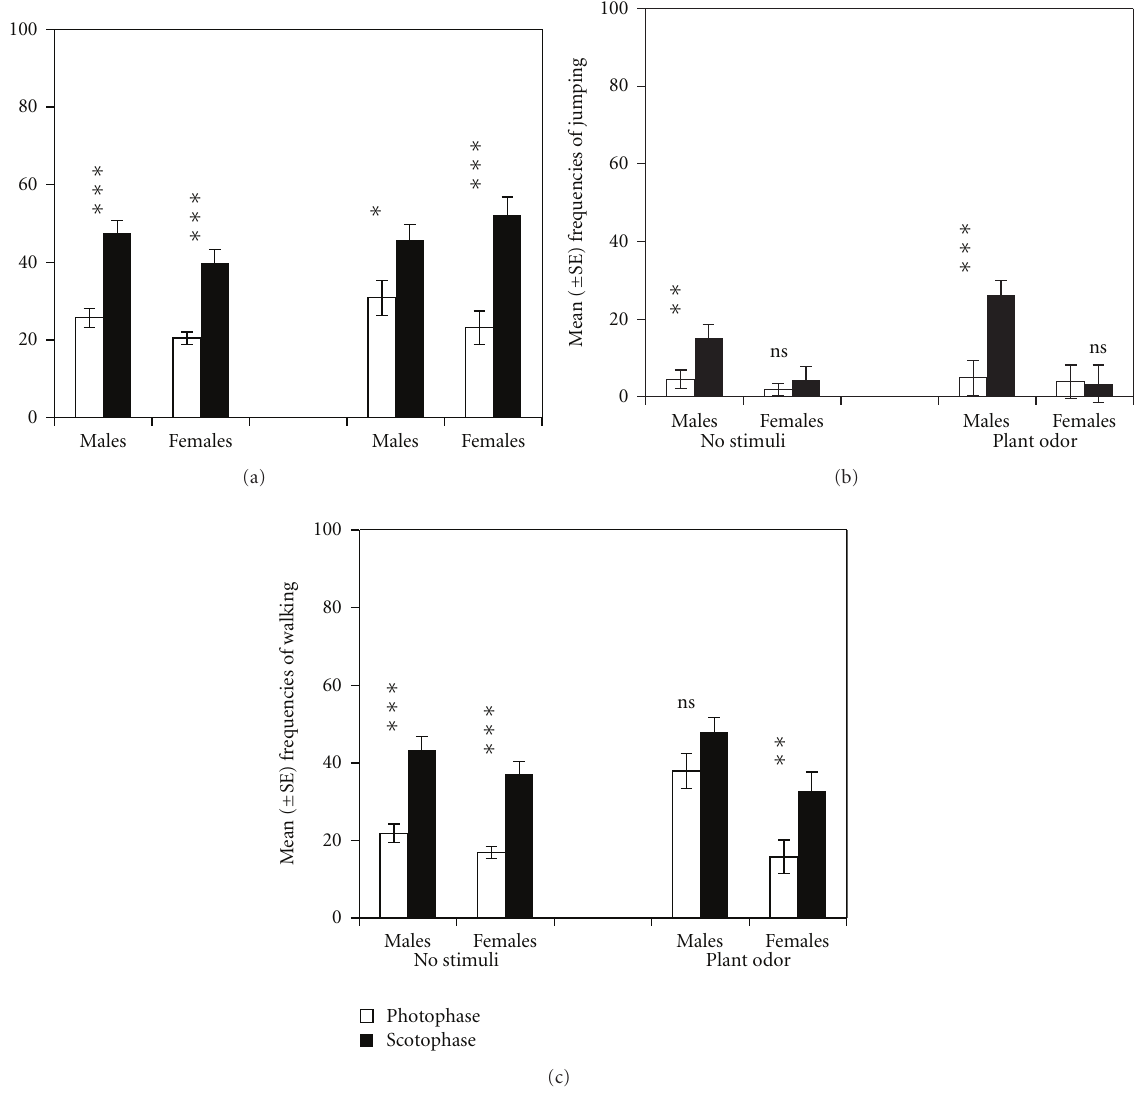
Figure 5: Di ff erence between photophase and scotophase activities of mature field-collected solitarious locusts. Bars represent standard errors ( ± SE); N = 80 insects used for each of the three behaviors. Student’s t test ( ∗∗∗ = significant at P < . 001; ∗∗ = significant at P < . 01; ∗ = significant at P < . 05; ns = not significant P > .